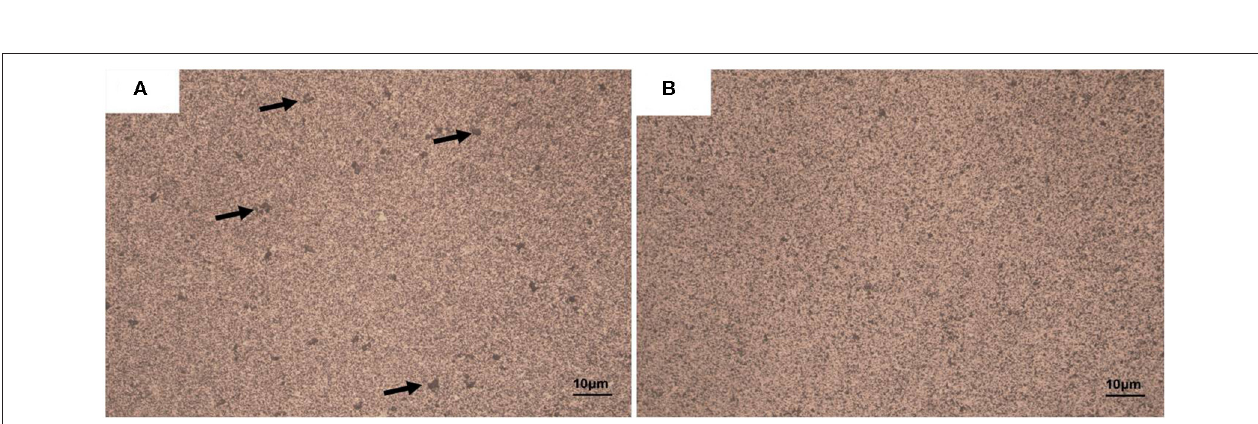
Frontiers in Materials | www.frontiersin.org